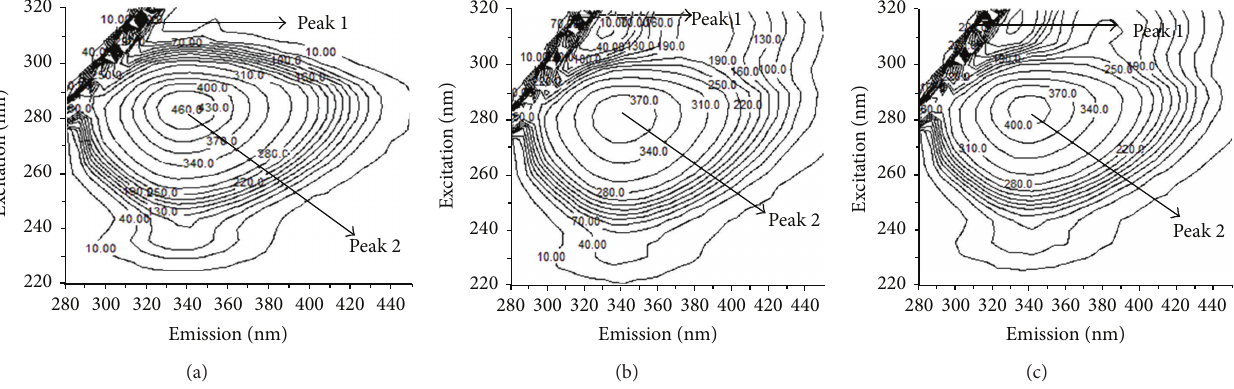
= 𝐶 = 4 × 10 −6 M, 𝐶 = ( warfarin ) ( ferulicacid ) HSA )